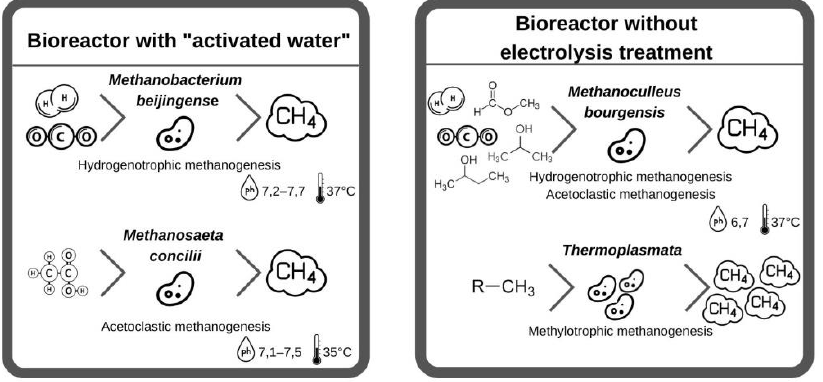
Figure 4. Comparison of bacterial bioprocesses in reactors with ‘activated water’ and without electrolysis treatment.